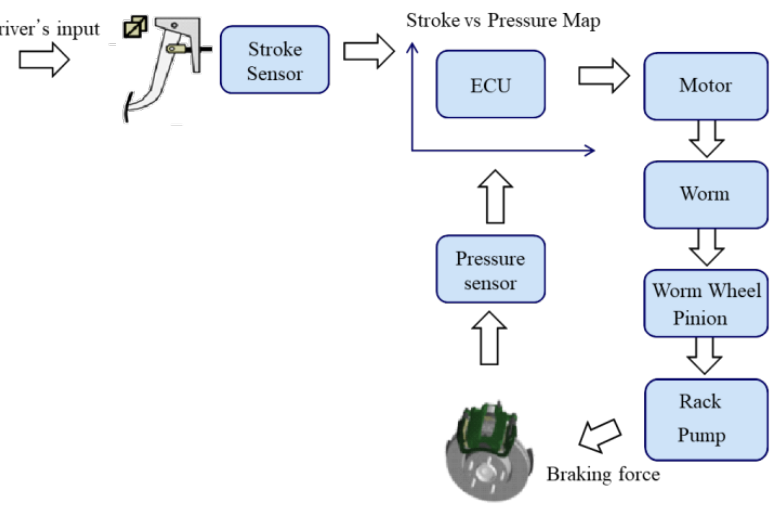
Figure 2. Operating sequence of the integrated electric brake system.